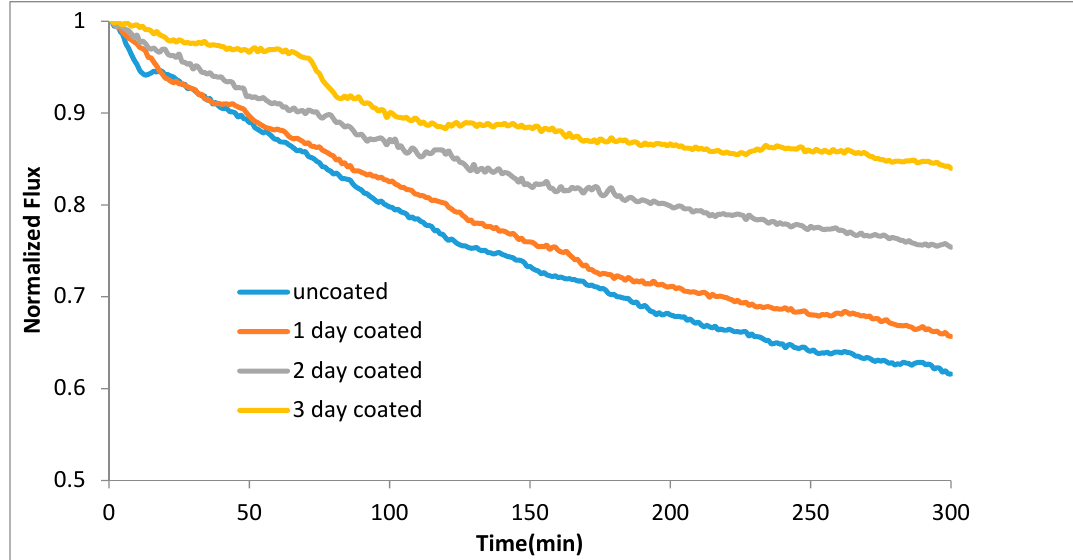
Figure 9. The normalized flux for the UF membranes (10 min average).